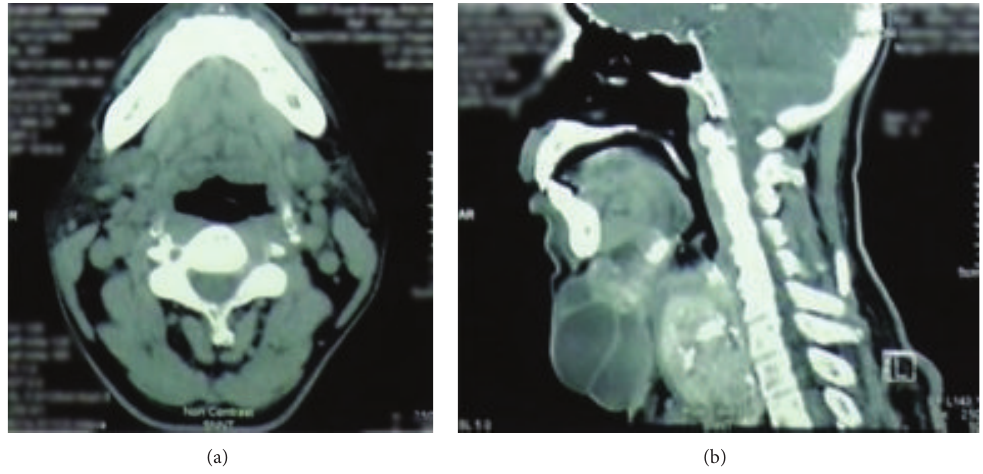
Figure 2: Axial and transverse section of a CT of the neck.